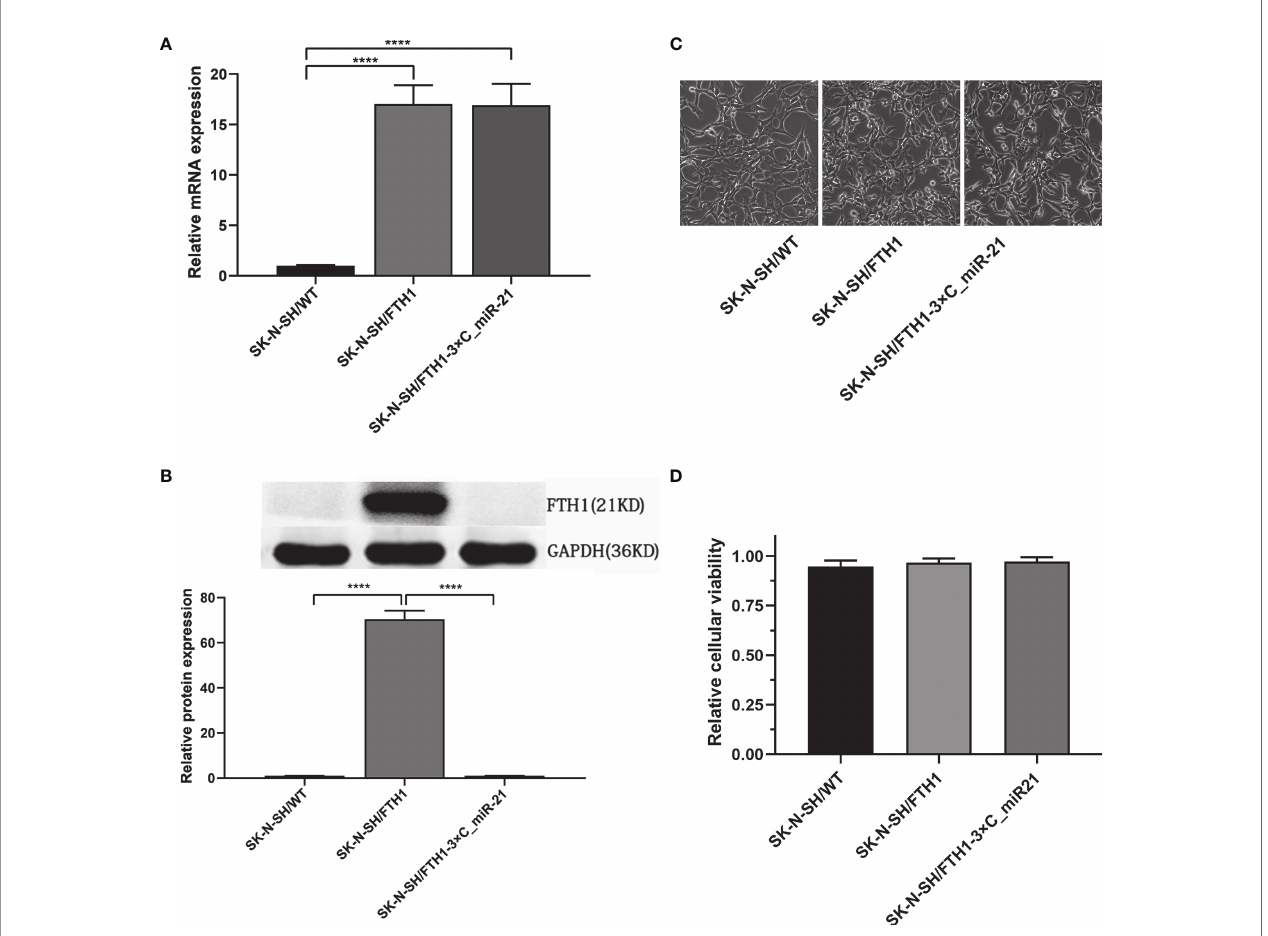
FIGURE 2 | FTH1 expression and its effect on viability in the three groups of cells. The qRT-PCR results (A) showed that the mRNA expression levels of the FTH1 gene in the SK-N-SH/FTH1 and SK-N-SH/FTH1-3 × C_miR-21 groups was similar, and both groups had signi fi cantly higher levels than the SK-N-SH/WT group. The WB results (B) showed that compared with the SK-N-SH/WT group, the SK-N-SH/FTH1 group showed signi fi cantly increased FTH1 expression at the protein level, while the SK-N-SH/FTH1-3×C_miR-21 group did not show alterations in FTH1 expression. No morphological changes were observed among the SK-N-SH/WT, SK- N-SH/FTH1 and SK-N-SH/FTH1-3×C_miR-21 cells (C) . The CCK-8 results revealed no difference in cell viability among the three groups (D) . Three independent experiments were performed. **** indicates P <